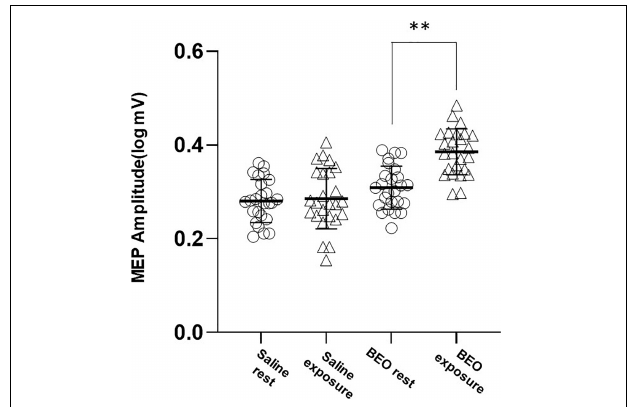
FIGURE 2 | Experiment 1 (perception): average amplitudes of logMEP before and after perception of either Saline or BEO. Perception of BEO significantly increased the amplitude of logMEP. Data are mean ± SD. ∗∗ p < 0.01.